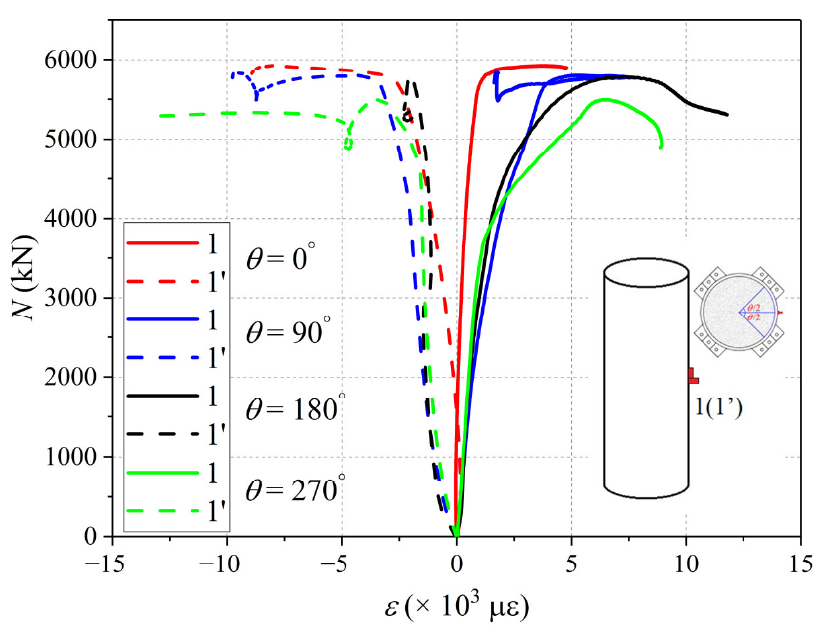
Figure 14. The N - ε curves at the gap part at a 1/2 height of the BWCFST specimens with interfacial gap with different θ .